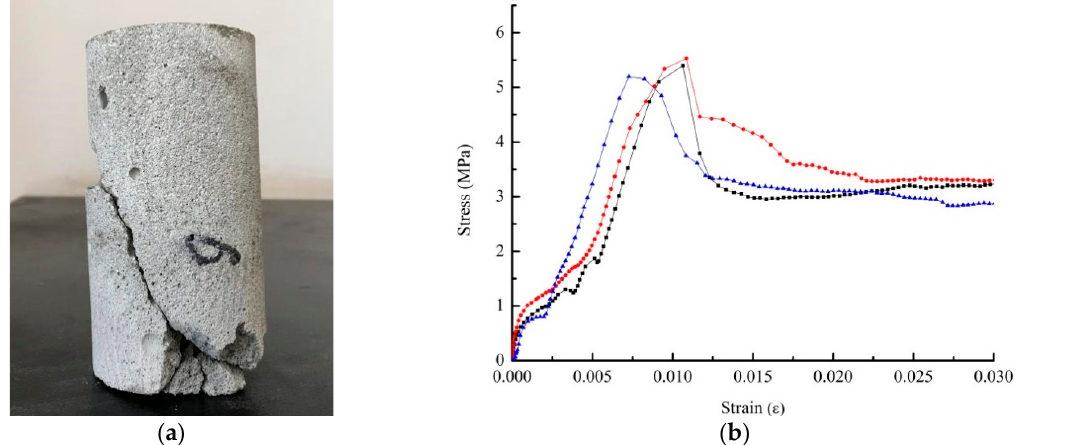
Figure 10. Mechanical response of foamed concrete with a density of 750 kg/m 3 . ( a ) The typical failure modes; ( b ) The stress-strain curve.